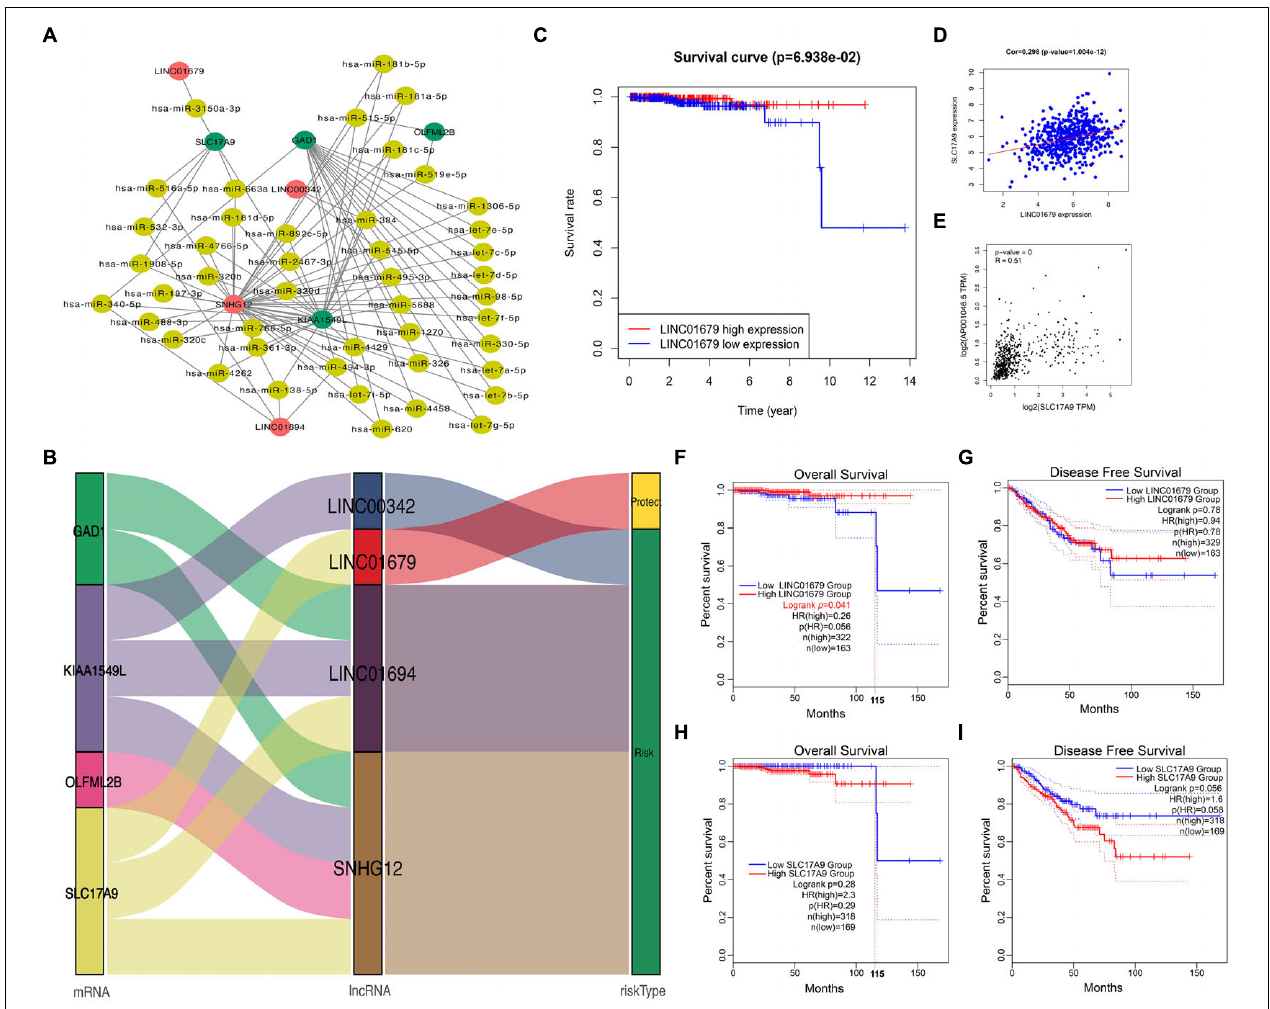
FIGURE 2 | Construction of a ceRNA regulatory network for PCa. (A,B) Construction of the four lncRNAs–mRNAs co-expression networks for predicting the OS of PCa, and network visualization by Sankey diagram and Cytoscape. (C) KM analysis on high and low LINC01679 levels. (D) Correlation analysis between LINC01679 expression and SLC17A9 expression based on TCGA database (D) and GEPIA database (E) . GEPIA database was used to analyze the role of LINC01679 in OS (F) and DFS (G) of PCa patients and the role of SLC17A9 in OS (H) and DFS (I) of PCa